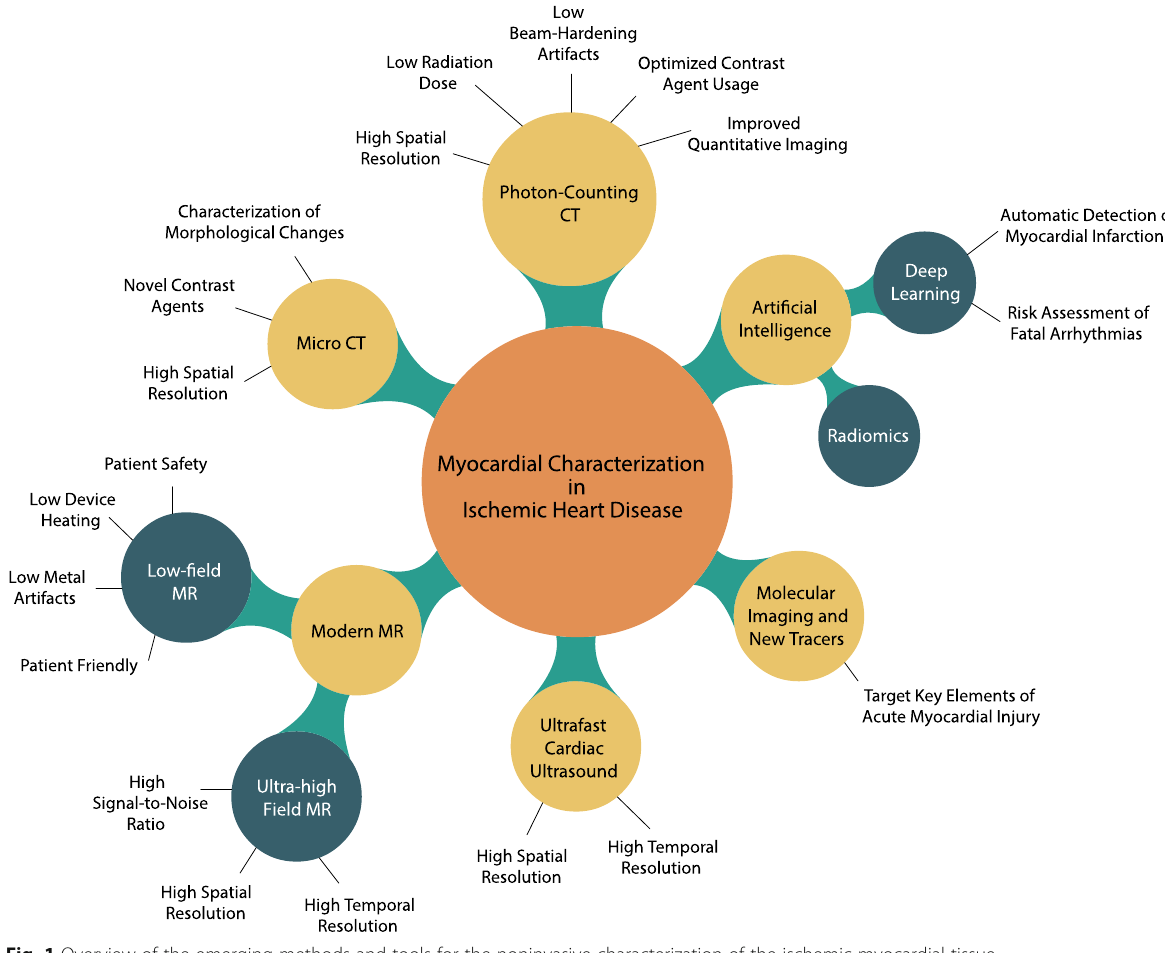
Fig. 1 Overview of the emerging methods and tools for the noninvasive characterization of the ischemic myocardial